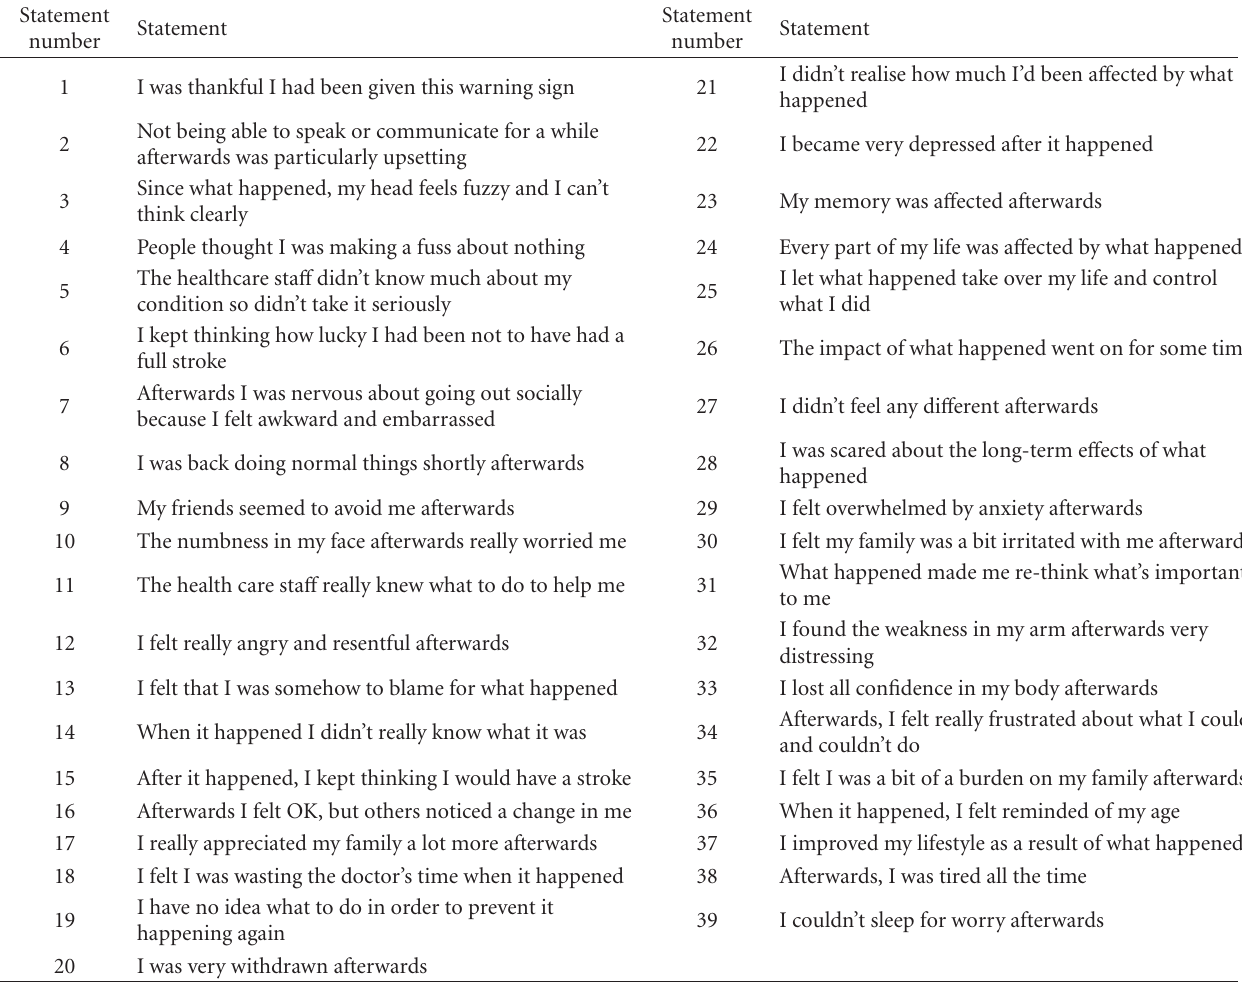
Table 1: The concourse